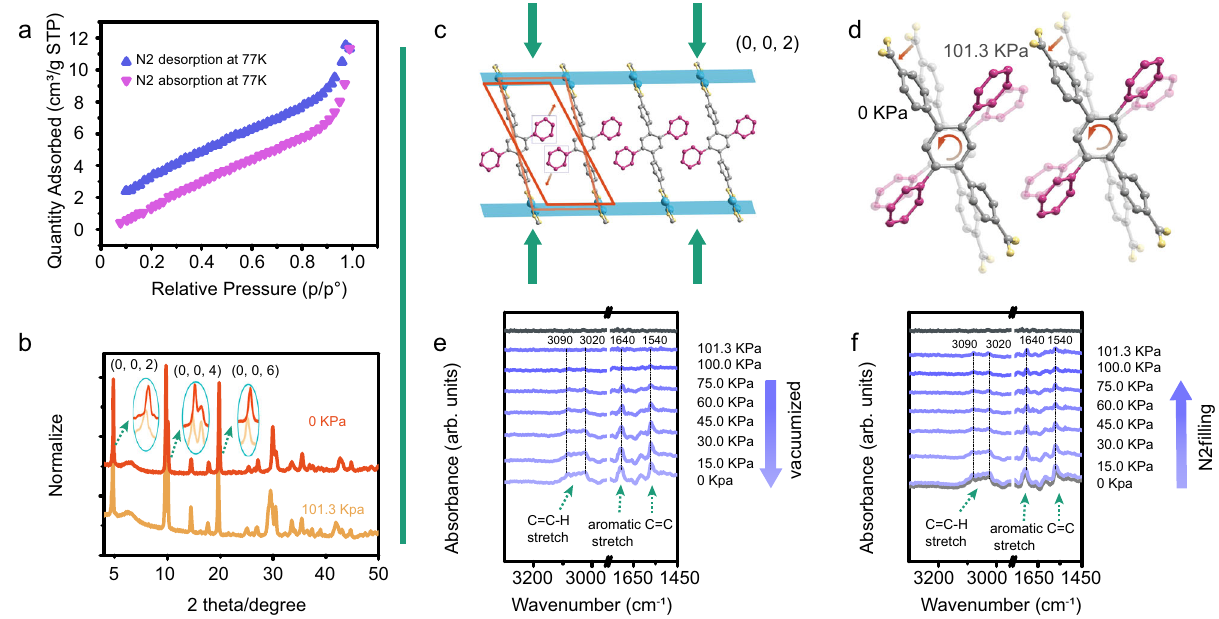
Fig. 6 Detection mechanism of FJI-H31. a The N 2 adsorption-desorption isotherms of FJI-H31(Gd) at 77 K. b The PXRD patterns of FJI-H31(Gd) at normal atmosphere and vacuum state. c The shrunken (0, 0, 2) face after vacuumized. d The proposed change of dangling phenyls. e The in situ FT-IR spectra recorded at different pressures during vacuumization, showing that the C-H stretching vibration and aromatic C = C stretching vibration become stronger, f while recover to originally upon fi lling N 2 ,